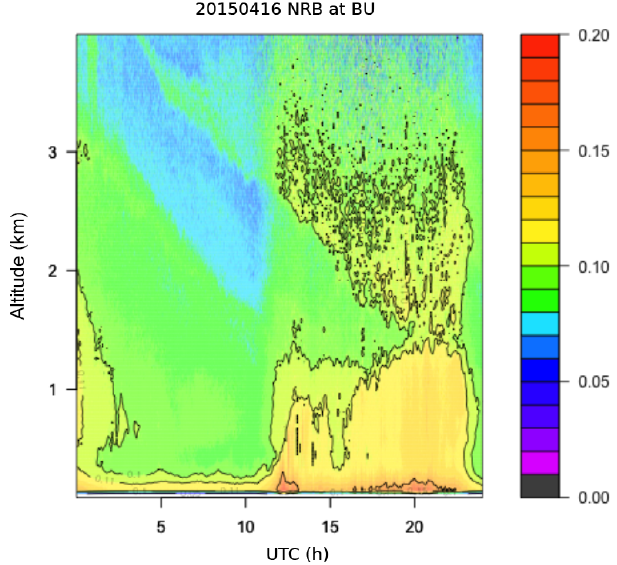
Figure H1. Lidar measurement on the roof of Boston University on 16 April